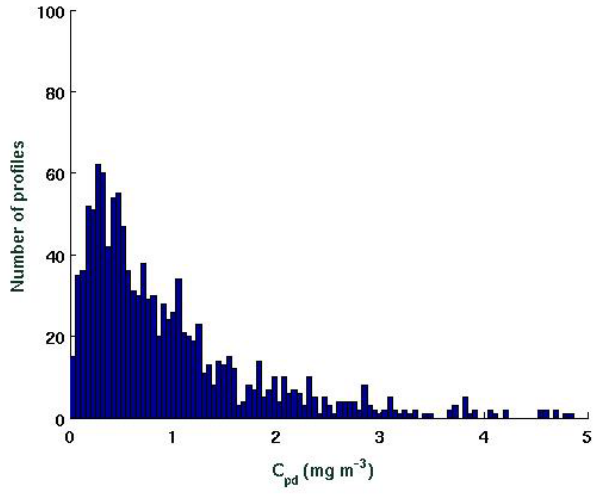
Fig. 2. Histogram describing the distribution of the mean chloro- phyll within the surface layer ( C pd ) over the 1199 chlorophyll pro-